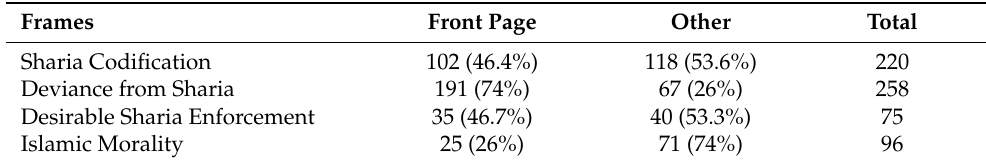
Table 7. The use of frames by the page